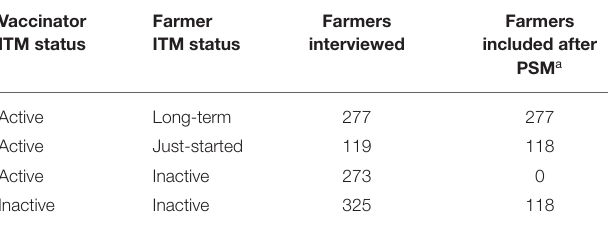
TABLE 1 | Survey data structure before and after propensity score matching. Vaccinator ITM status